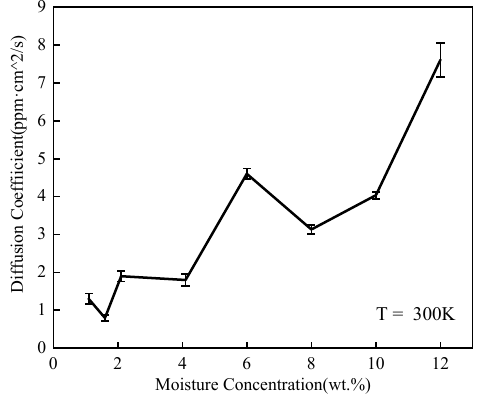
Figure 10. Diffusion coefficients for various moisture concentrations.